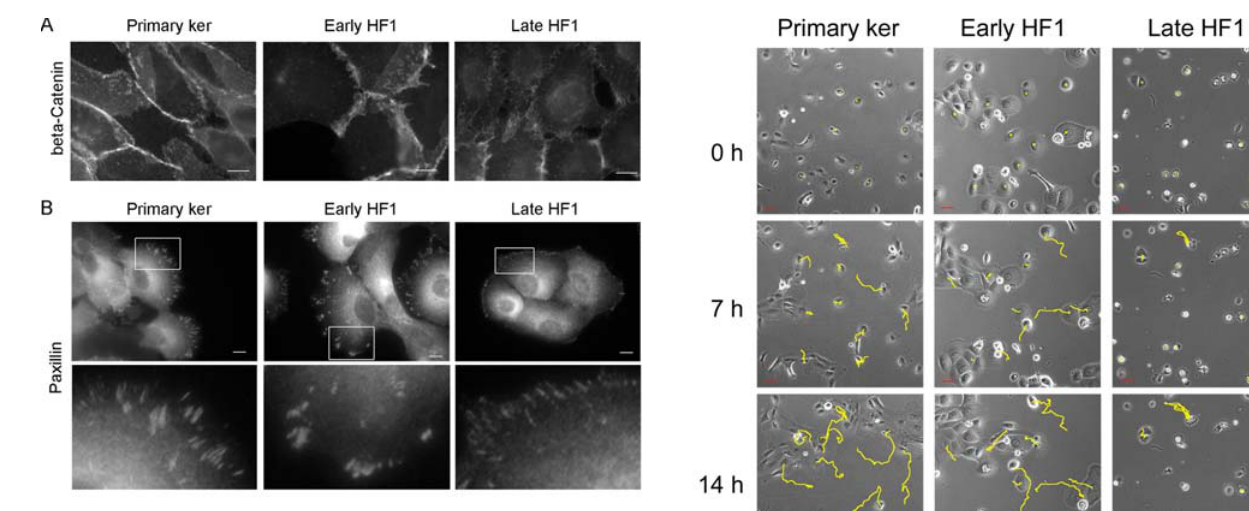
Figure 2. Representative immuno-fluorescence images of primary keratinotyes, early and late HF1 cells. A. Staining with anti-beta-Catenin antibody. B. Staining with anti-Paxillin antibody. Bar=15 m m. Enlargements of focal adhesions are shown